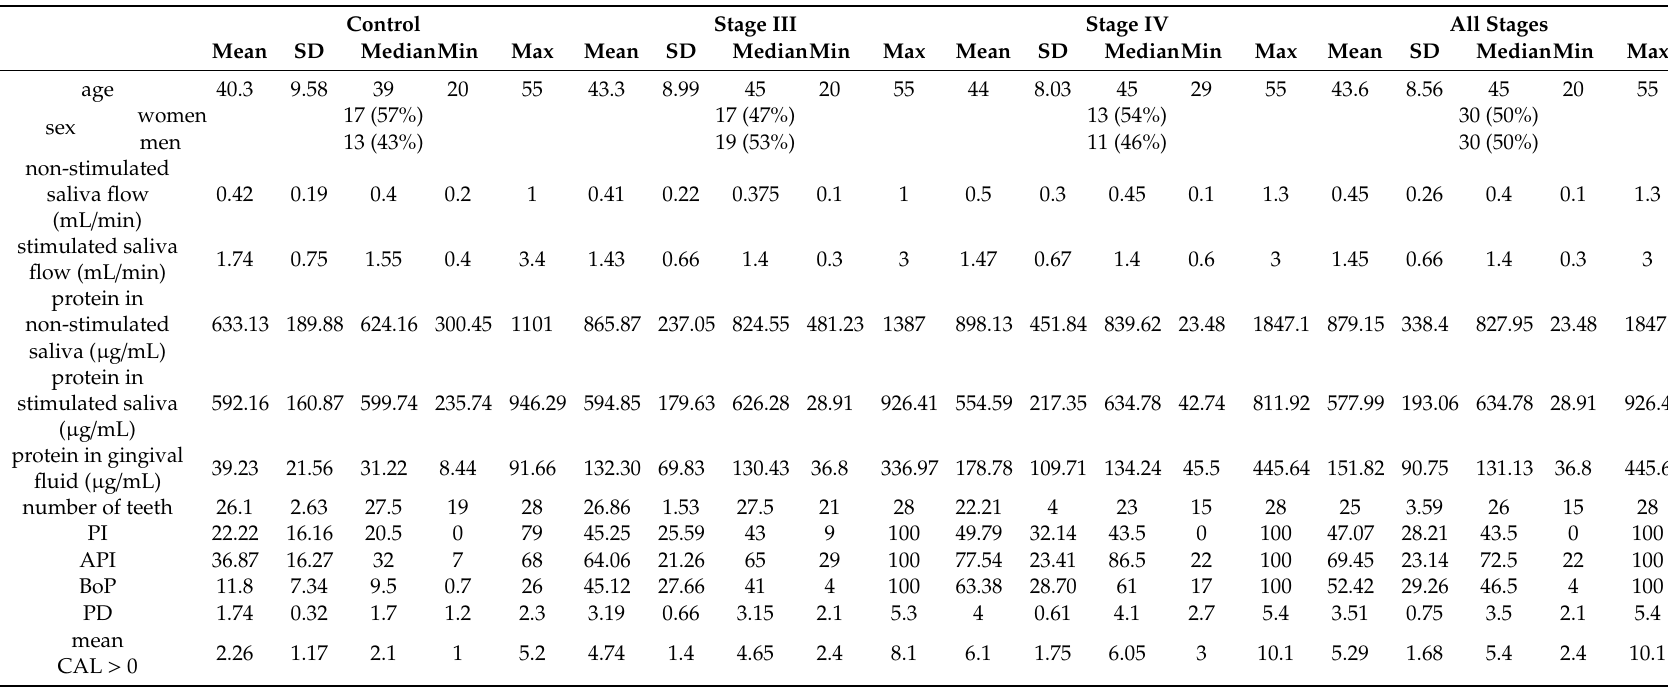
Table 1. General and periodontal